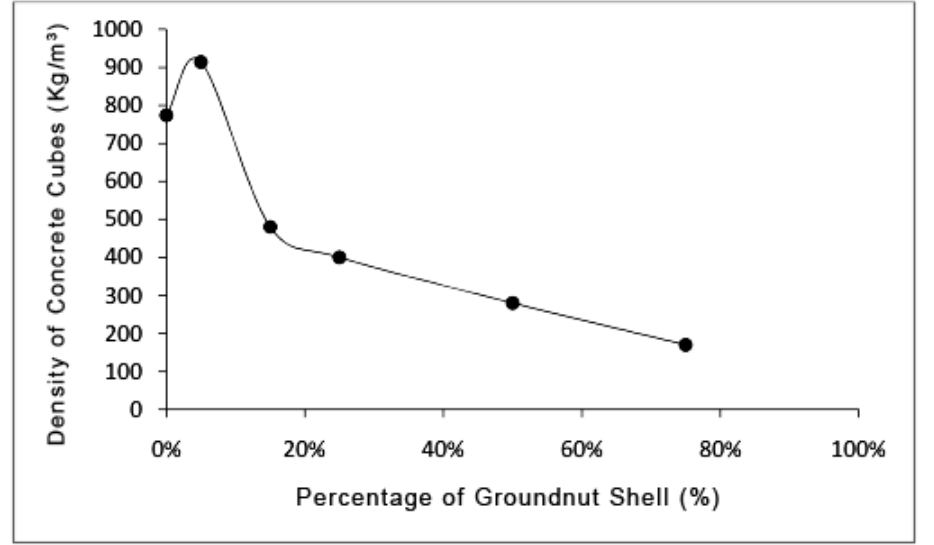
Figure 5. Compressive strength variation based on groundnut shells percentage levels [40].